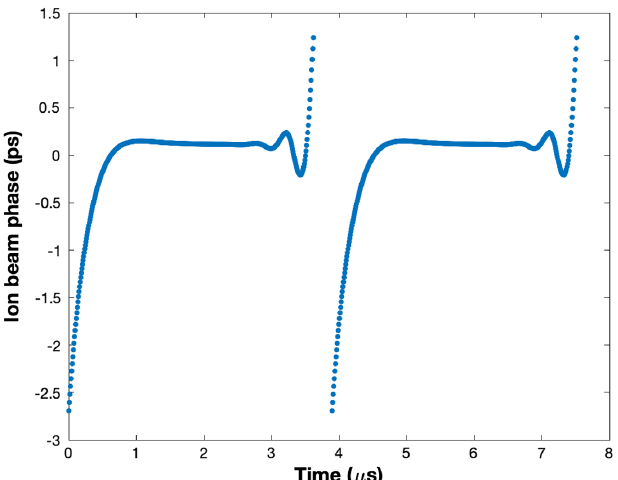
FIG. 7. Ion beam synchronous phase transient.